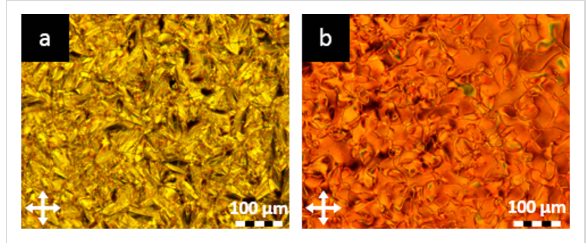
Figure 2: Representative POM images of NO 2 -C 10 at 94 °C (a) and NO 2 -C 10 ∙∙∙ F 4 Az at 61.5 °C (b) upon cooling from the isotropic melt.